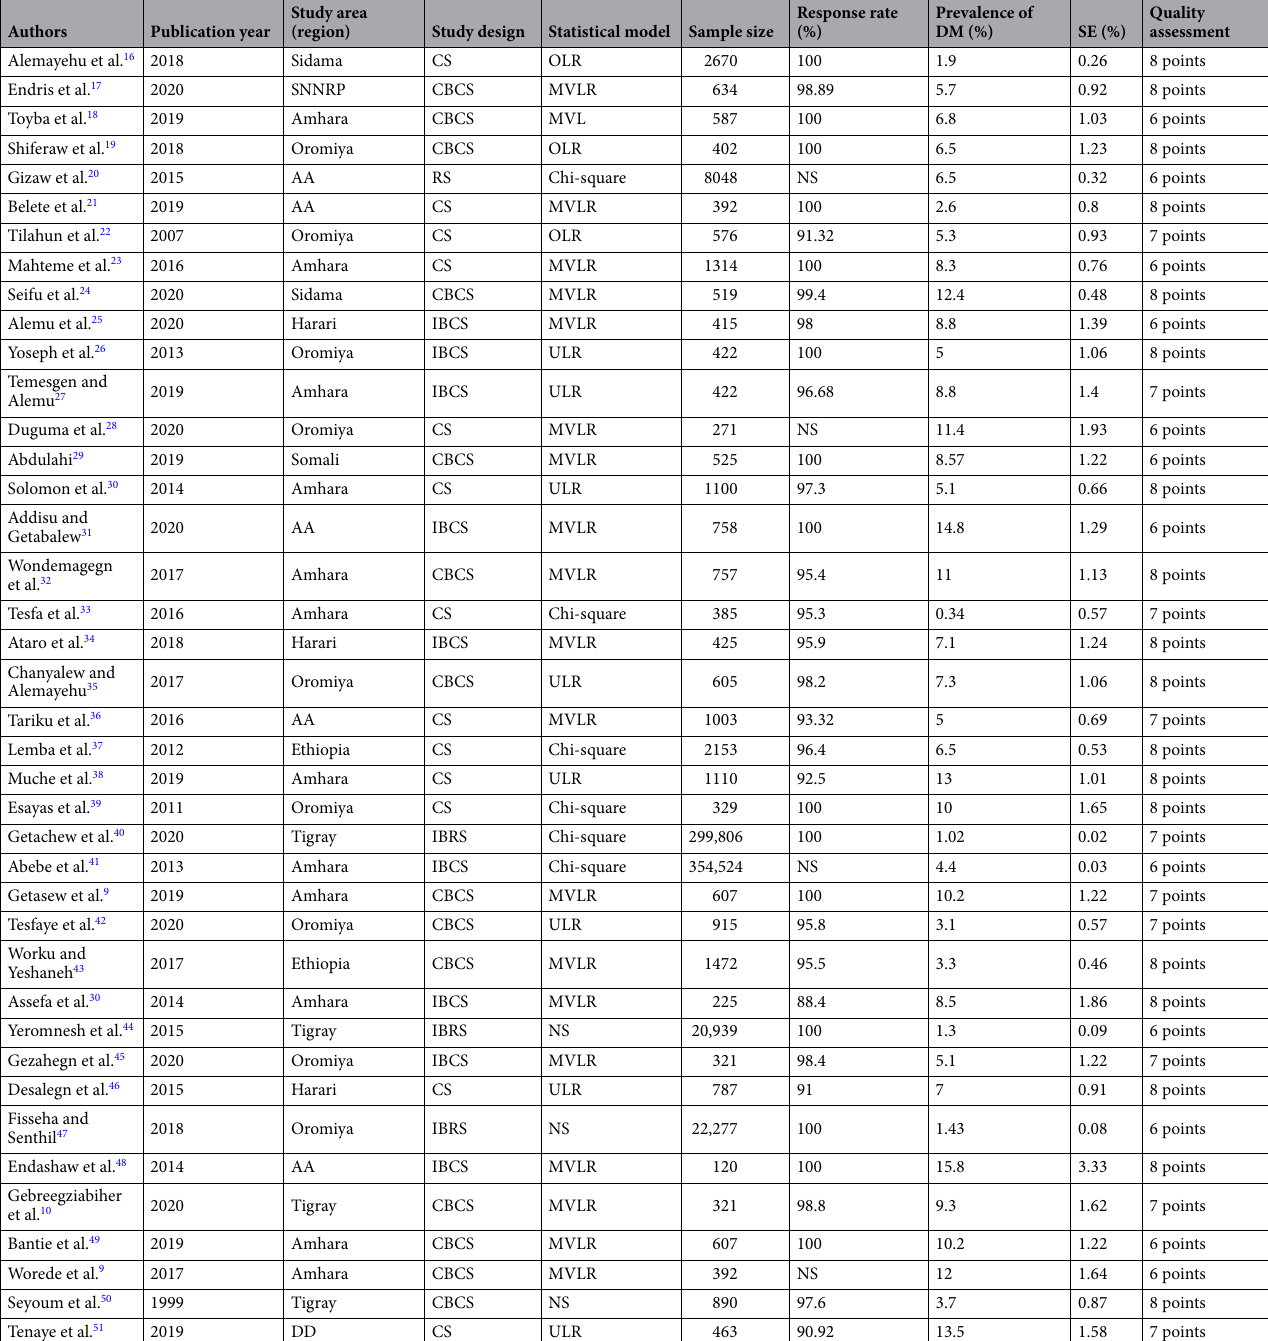
Table 1. Characteristics of the studies included and their prevalence of DM (N = 40). Acronyms: AA Addis Ababa, CBCS community-based cross sectional study, CS cross-sectional study, DD Dire Dawa, DM diabetes mellitus, FBCS facility based cross sectional study, IBCS institution based cross sectional study, HBRS hospital- based retrospective study, RS retrospective study, NS not specified, OLR ordinal logistic regression, MVLR multivariate logistic regression, ULR uni-variate logistic